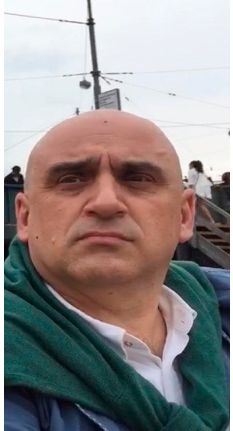
Figure 1. Pedro Cera. 2018. © Santiago Cera